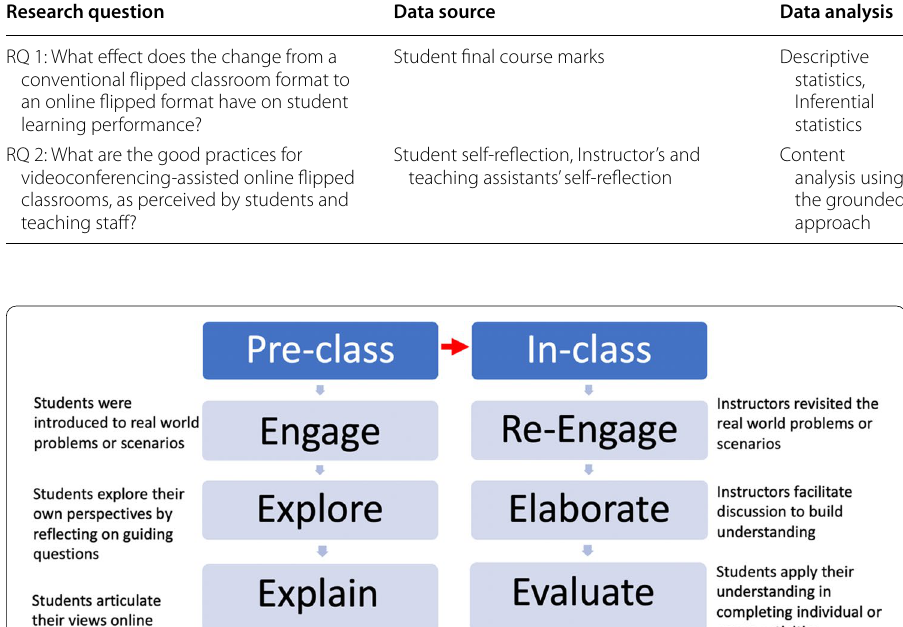
Table 2 Summary of research questions, data collection, and analyses Research question